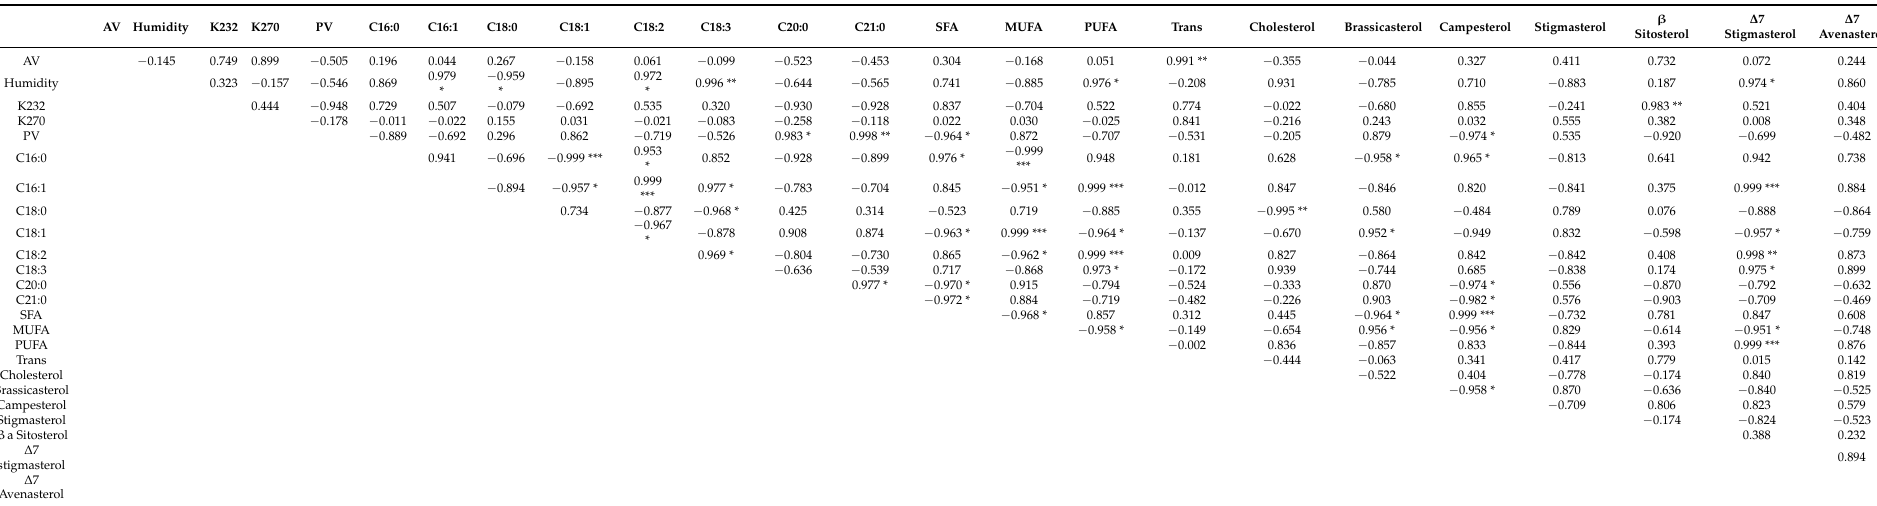
Table 4. Correlation coefficients (Pearson correlation) among the studied olive oil physiochemical traits. * Significant at 0.05 probability level, ** Significant at 0.01 probability level, *** Significant at 0.001 probability